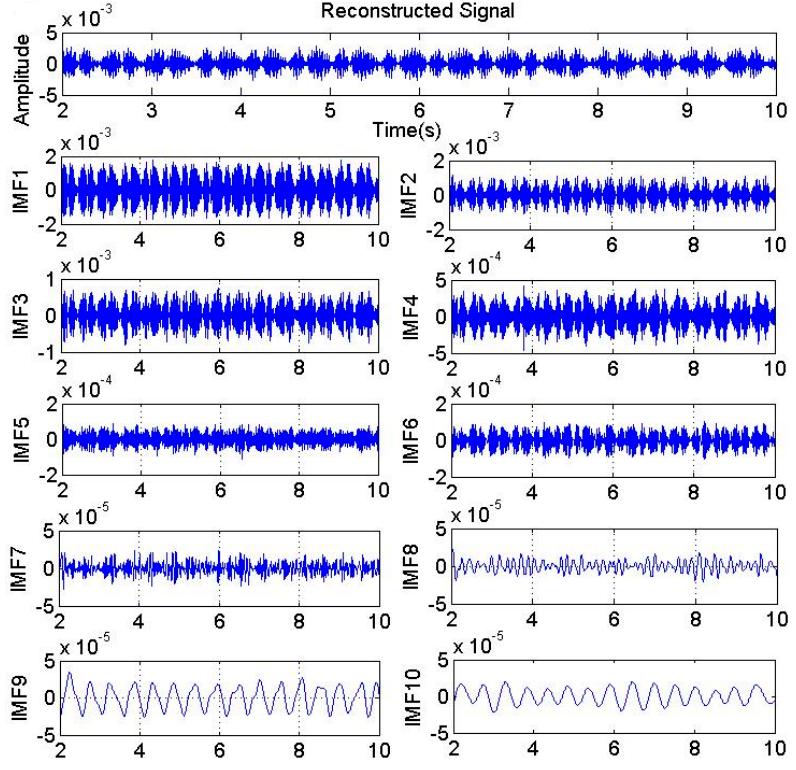
Figure 5. Ensemble empirical mode decomposition.